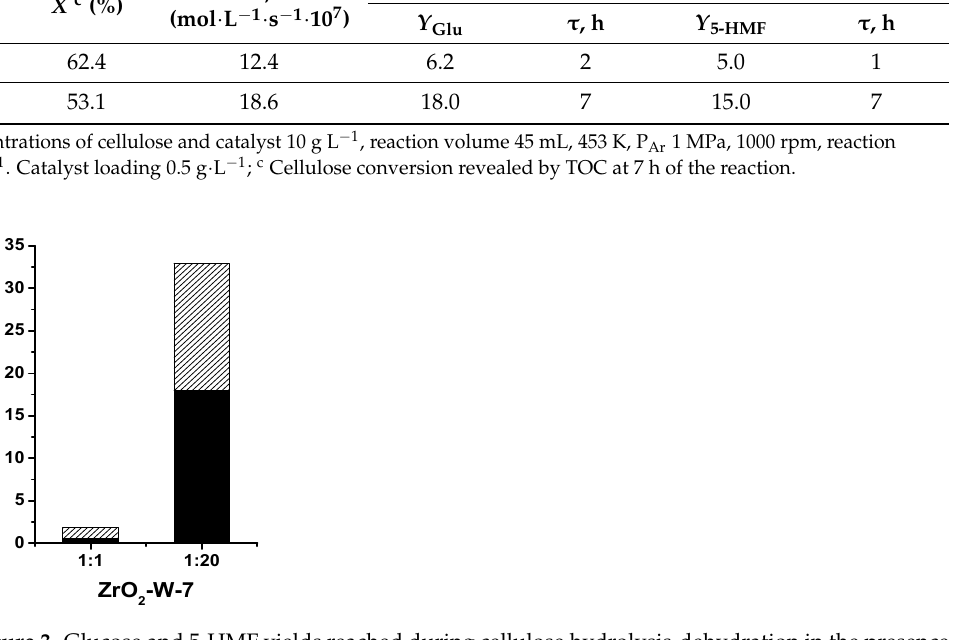
Table 5. One-pot depolymerization of cellulose to glucose and 5-HMF in the presence of ZrO 2 -W-7 at [Cat]/[Cell] ratios 1:1 and 1:20 g·g − 1 a . Catalyst Sample